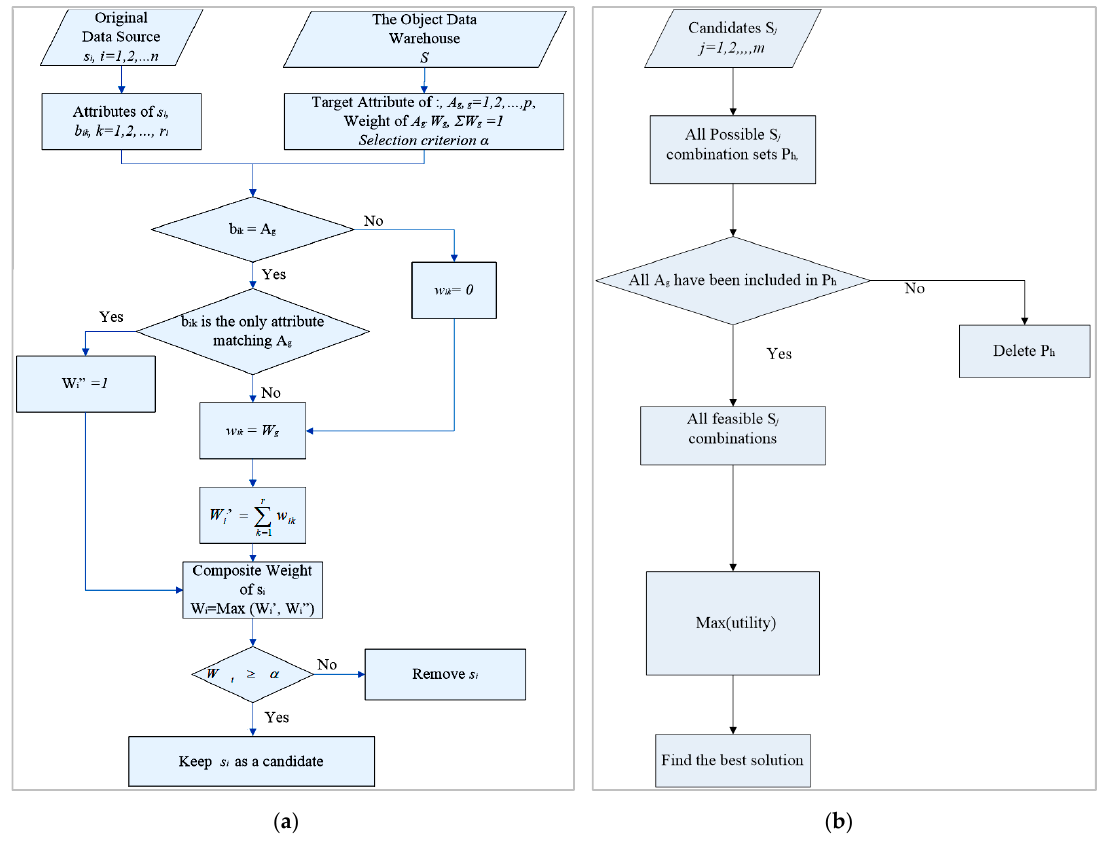
Figure 2. Data mining and integration flowchart: ( a ) data mining model and ( b ) data integration